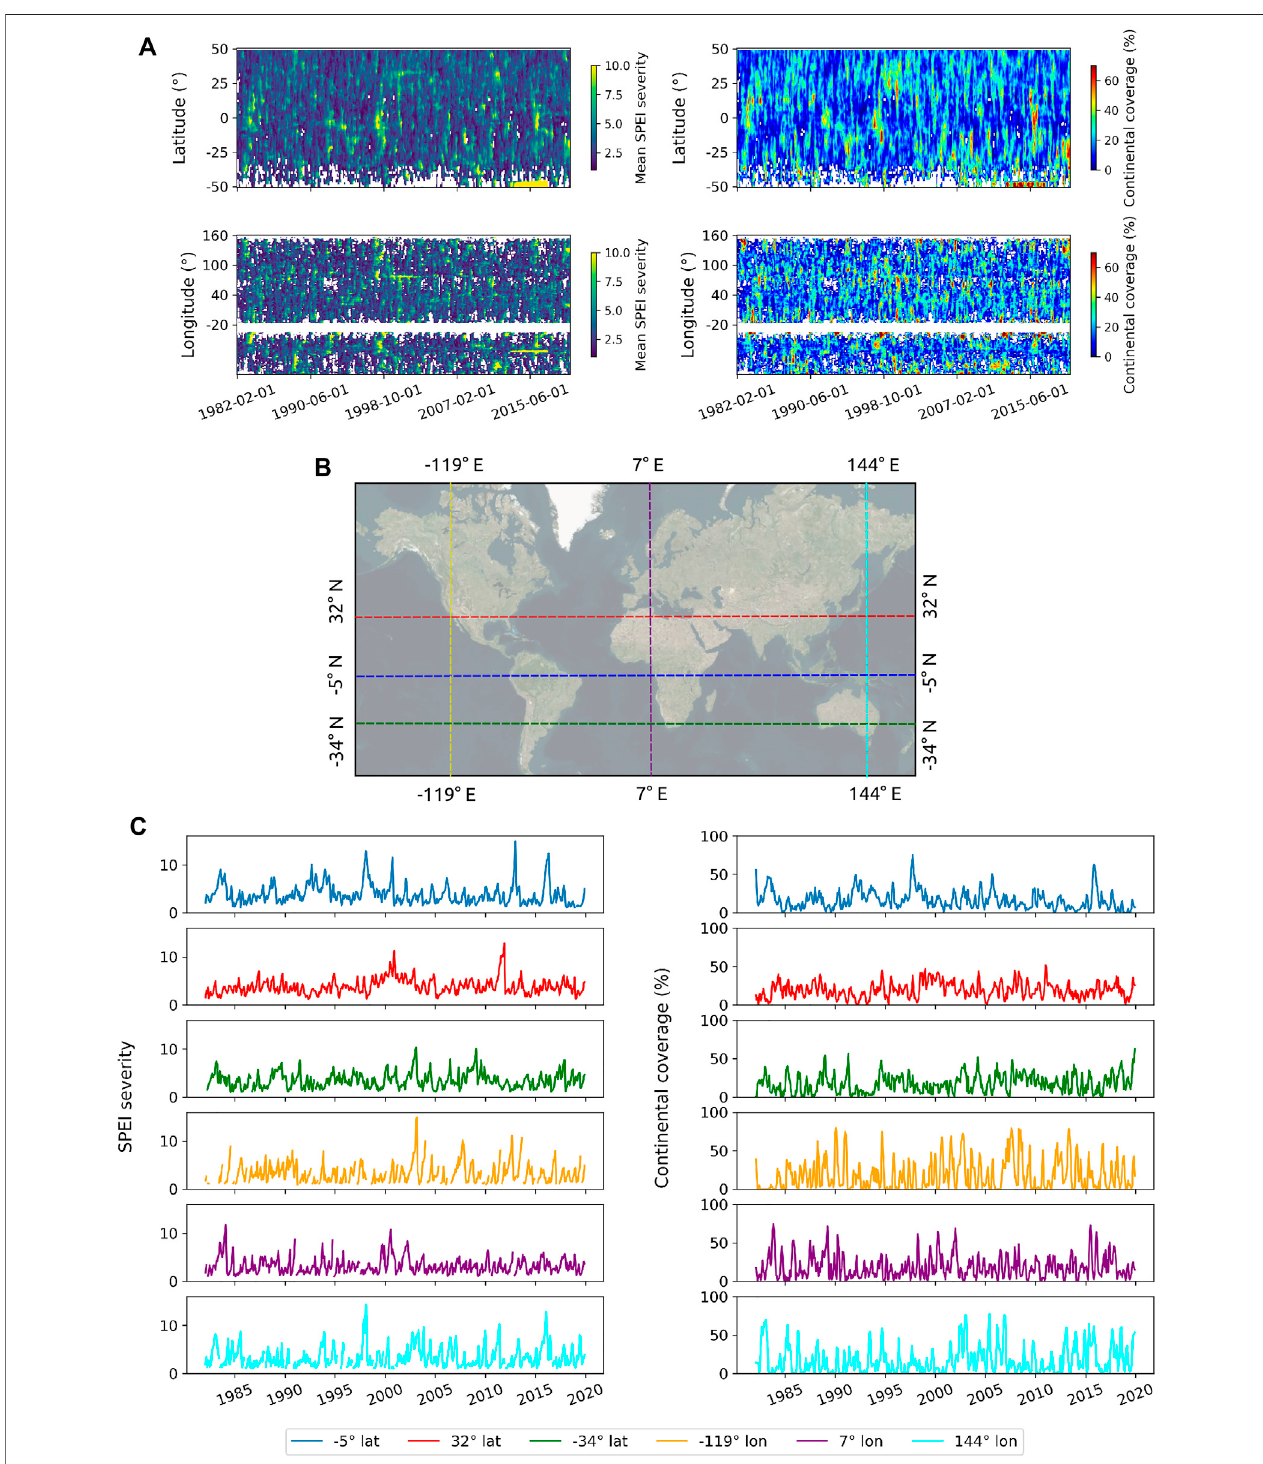
FIGURE 12 | Heat maps (A) of mean 3-month SPEI severity by latitude and longitude (B) with the corresponding latitudinal and longitudinal continental coverage [percentage of latitudinal/longitudinal continental extent affected by drought; (C) ]. Examples of three parallel and meridian mean SPEI severity time series and their corresponding continental extents (%) are in the middle and lower panels.